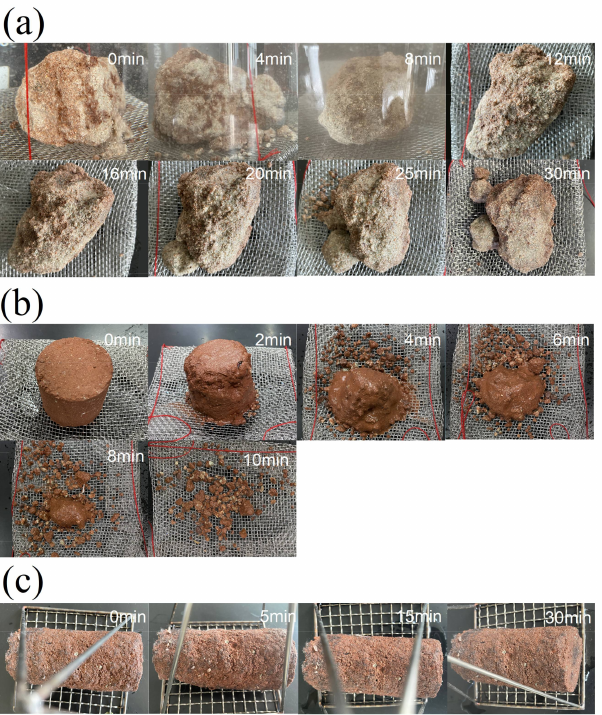
Figure 10. Photograph of sample disintegration process: ( a ) 1-0; ( b ) 1-F; ( c ) improved